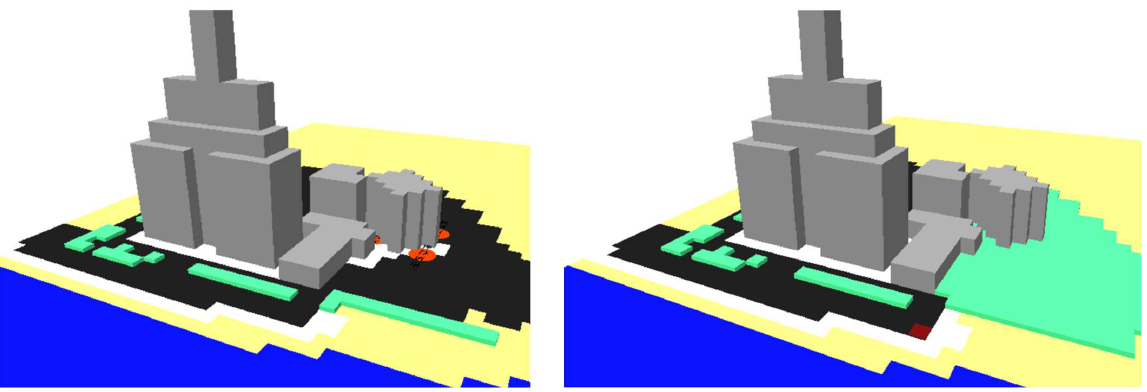
Figure 9. The existing base case with hard surfaces ( left ) and the amended scenario with green spaces ( right